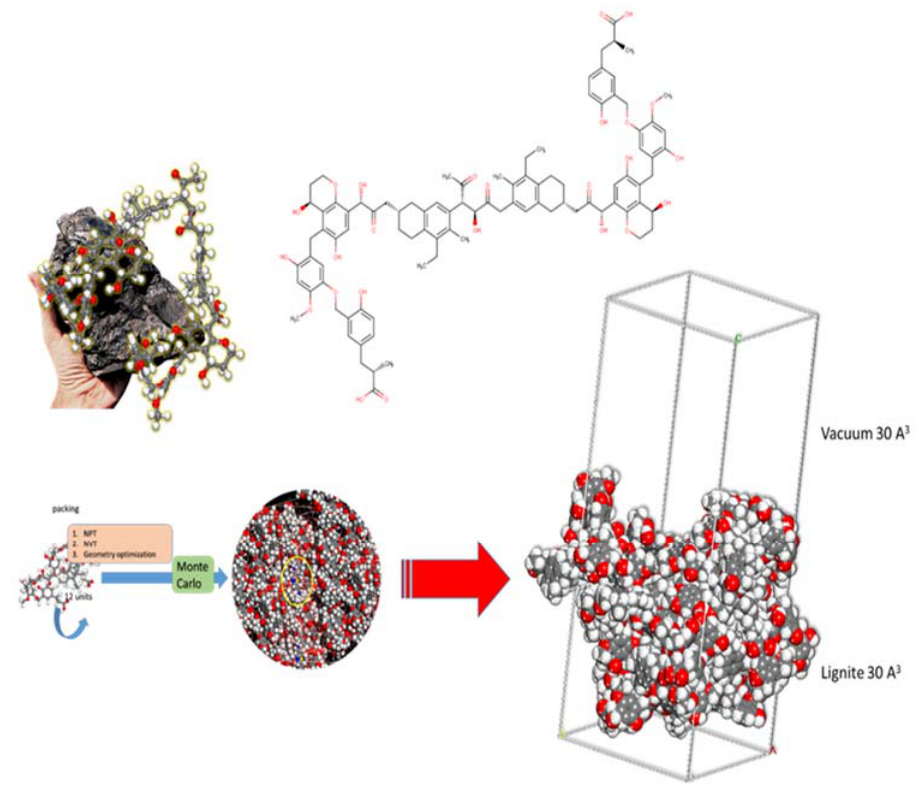
Figure 12. Representation of the parts of 3D and 2D chemical structures used as a starting point to construct Periodic Boundary Conditions (PBC) model of lignite used in Monte Carlo calculations (via packing, NPT, NVT, and geometry optimization).